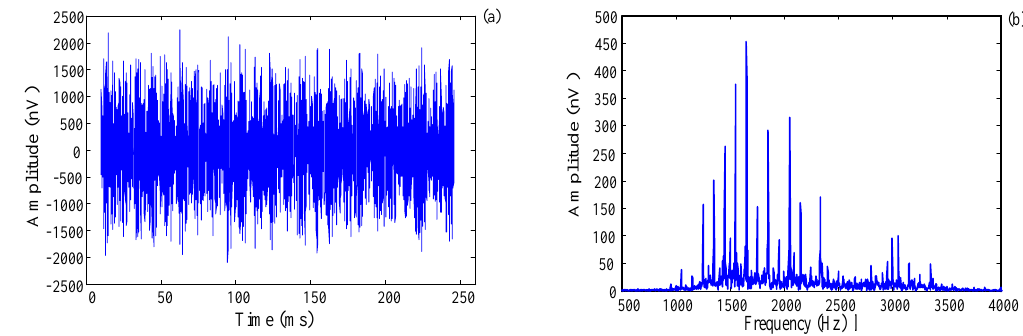
Figure 10. Noisy MRS signal [ ] s n obtained by stacking. ( a ) The noisy MRS signal in the time ( b ) the corresponding amplitude spectrum in the frequency domain. domain; ( b ) the corresponding amplitude spectrum in the frequency domain.